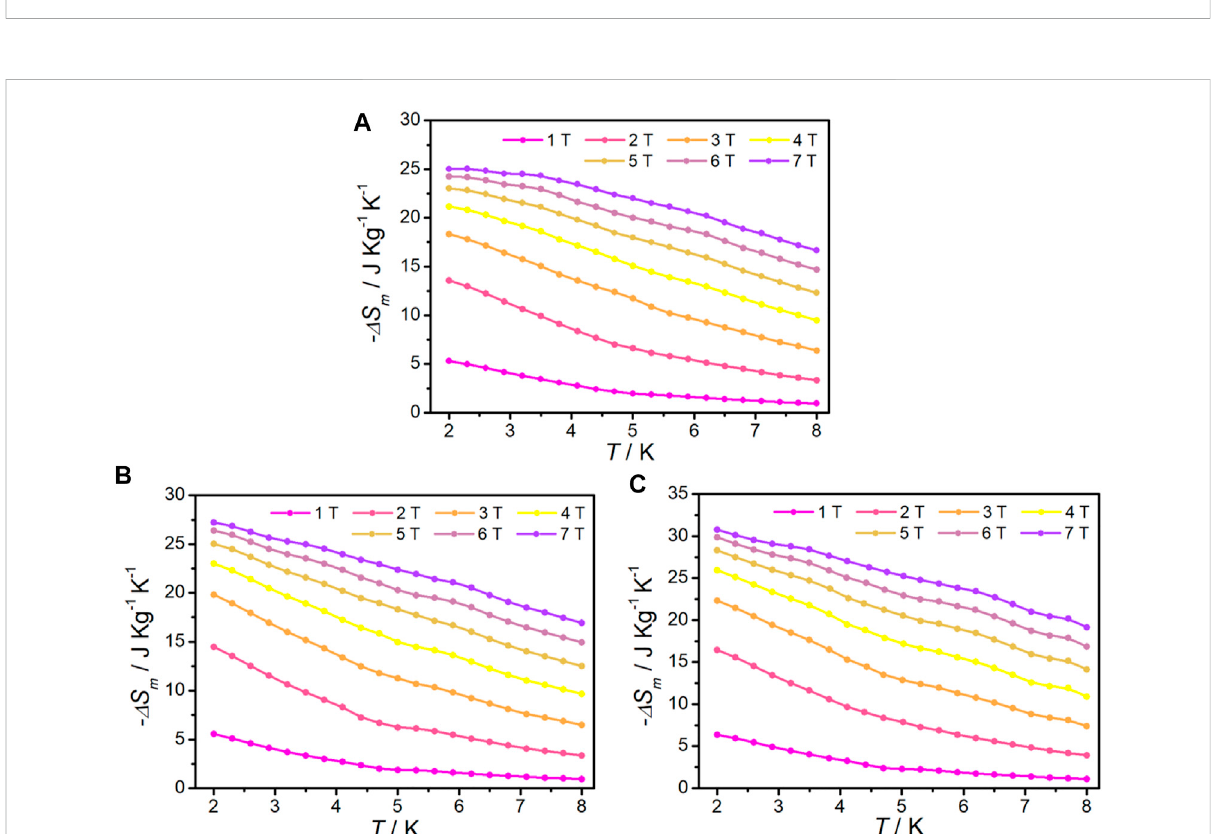
FIGURE 5 - Δ S m at various fi elds and temperatures, calculated from the magnetization data for 1(A) , 2(B) , and 3(C) .